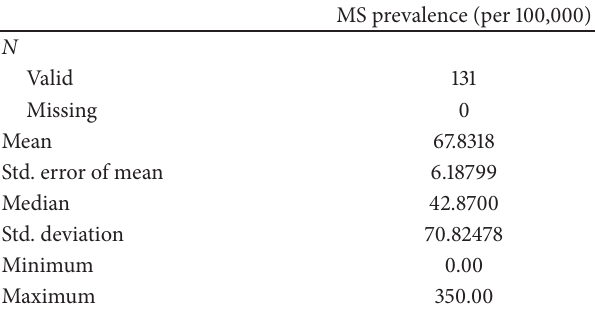
Table 2: Sample dataset table of latitude and longitude and preva- lence.